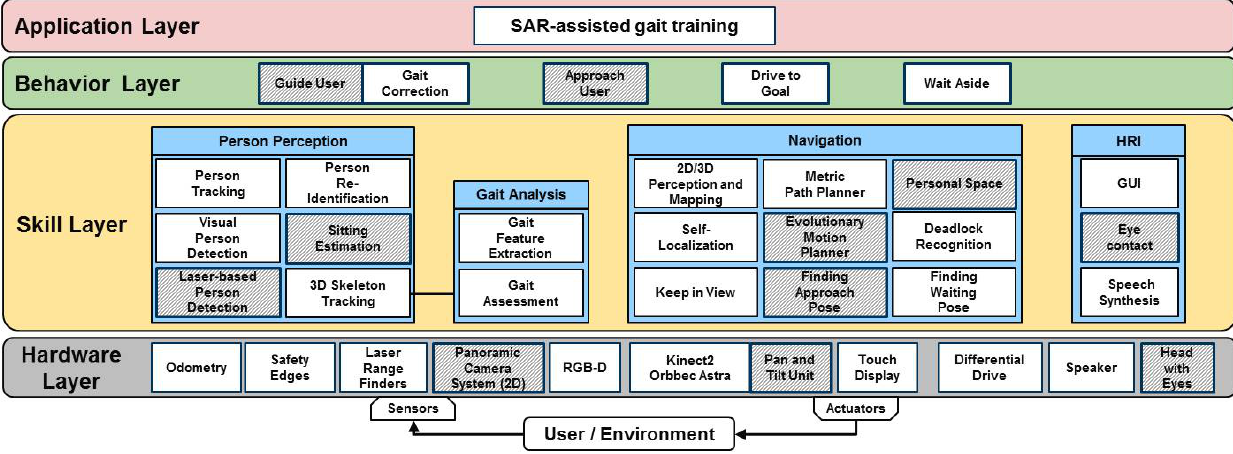
Figure 4. Multilayered functional system architecture of both self-training robots consisting of a Hardware Layer to control the onboard sensors and actuators, a Skill Layer with person perception, gait analysis, navigation, and HRI-specific methods and skills, a Behavior Layer comprising more complex skills, and an Application Layer implementing the whole training session. The shaded modules are used for the research platform